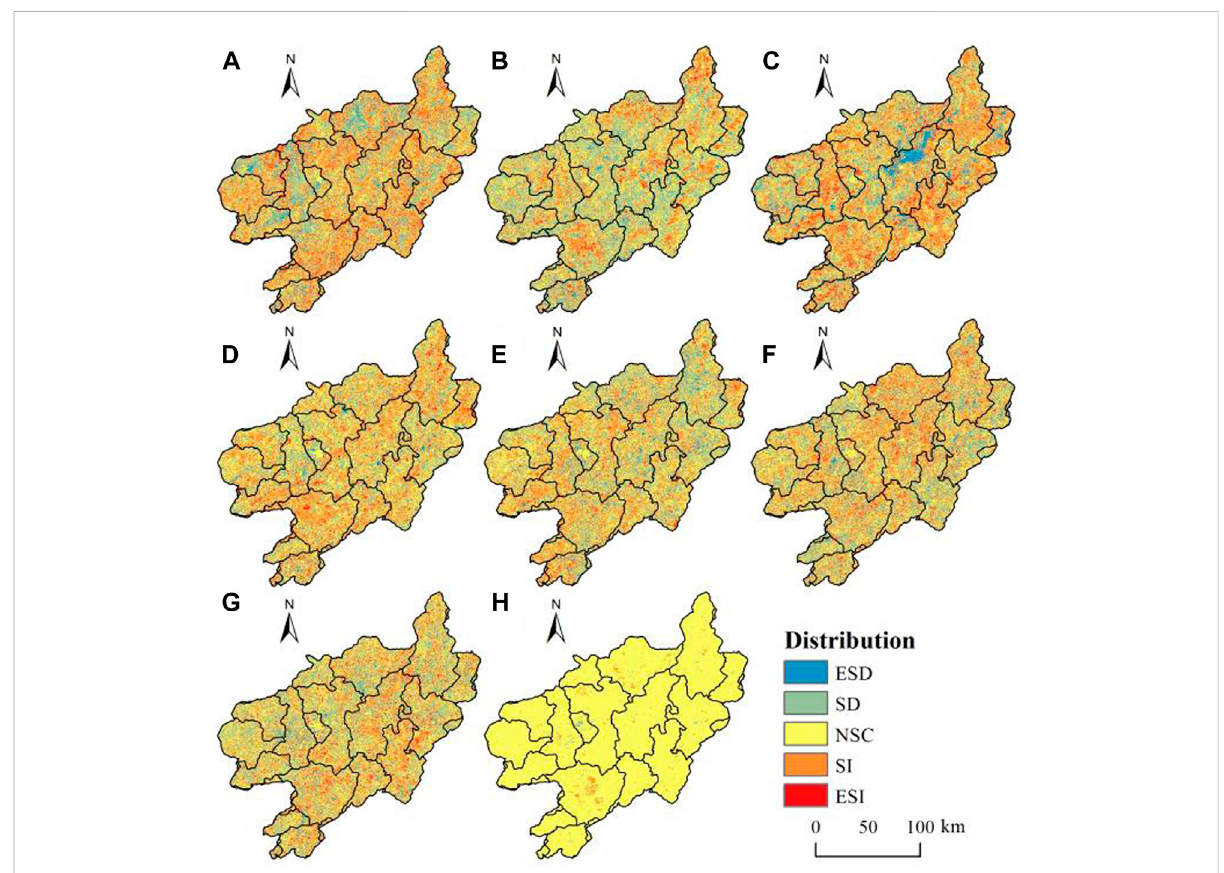
FIGURE 6 Evolution trend of changes in vegetation coverage in the upper reaches of Ganjiang River Basin from 2000 to 2020. (A – H) are for the sub- periods of 2000 – 2002, 2003 – 2003, 2006 – 2008, 2009 – 2011, 2012 – 2014, 2015 – 2017, 2018 – 2020, and 2000 – 2020, respectively. ESD, SD, NSC, SI, and ESI denote extremely signi fi cant decrease, signi fi cant decrease, non-signi fi cant change, signi fi cant increase, and extremely signi fi cant increase,